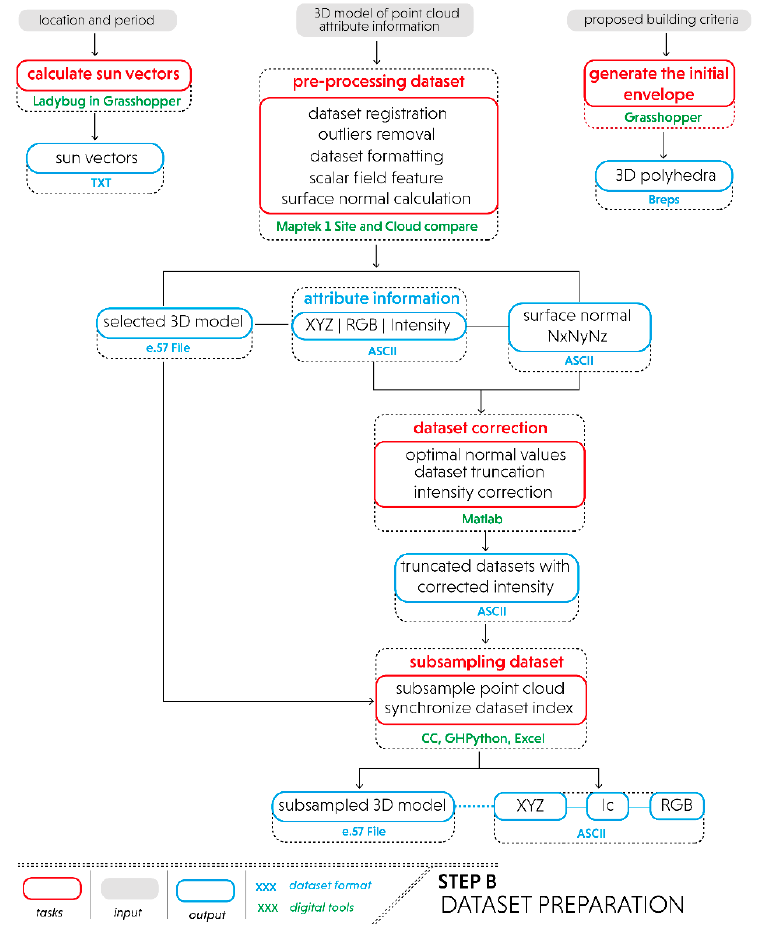
Figure 3. Detailed procedures for the dataset preparation.